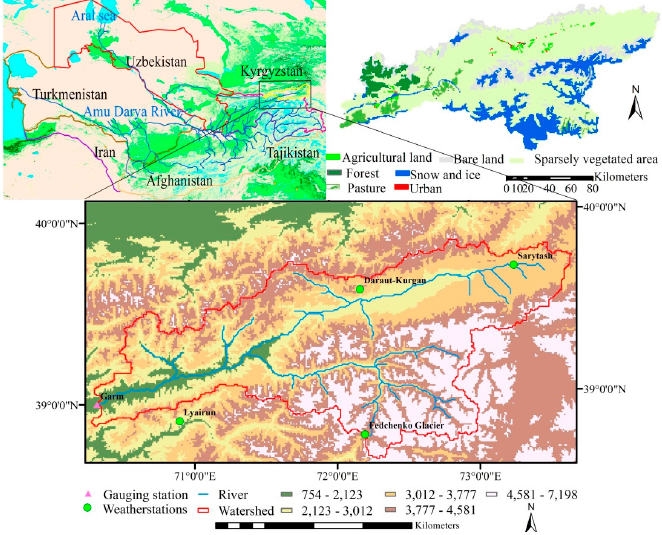
Figure 1. Location of the study area in the Amu Darya River Basin and the land cover map.